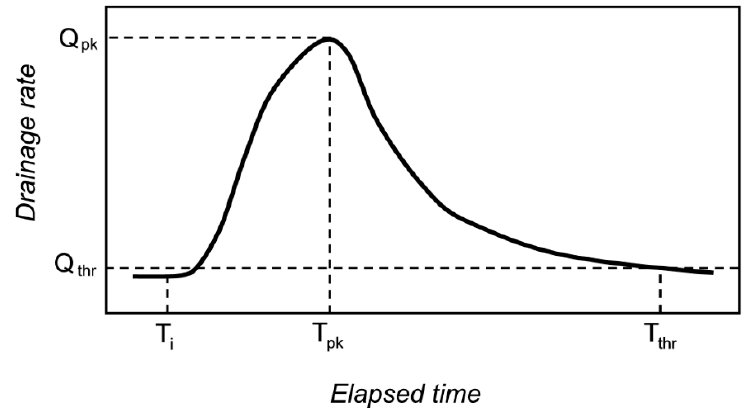
Figure 3. A conceptual drawing of mesocosm drainage rate in response to an input of stormwater. Following each application of stormwater, we quantified the drainage volume (drainage volume